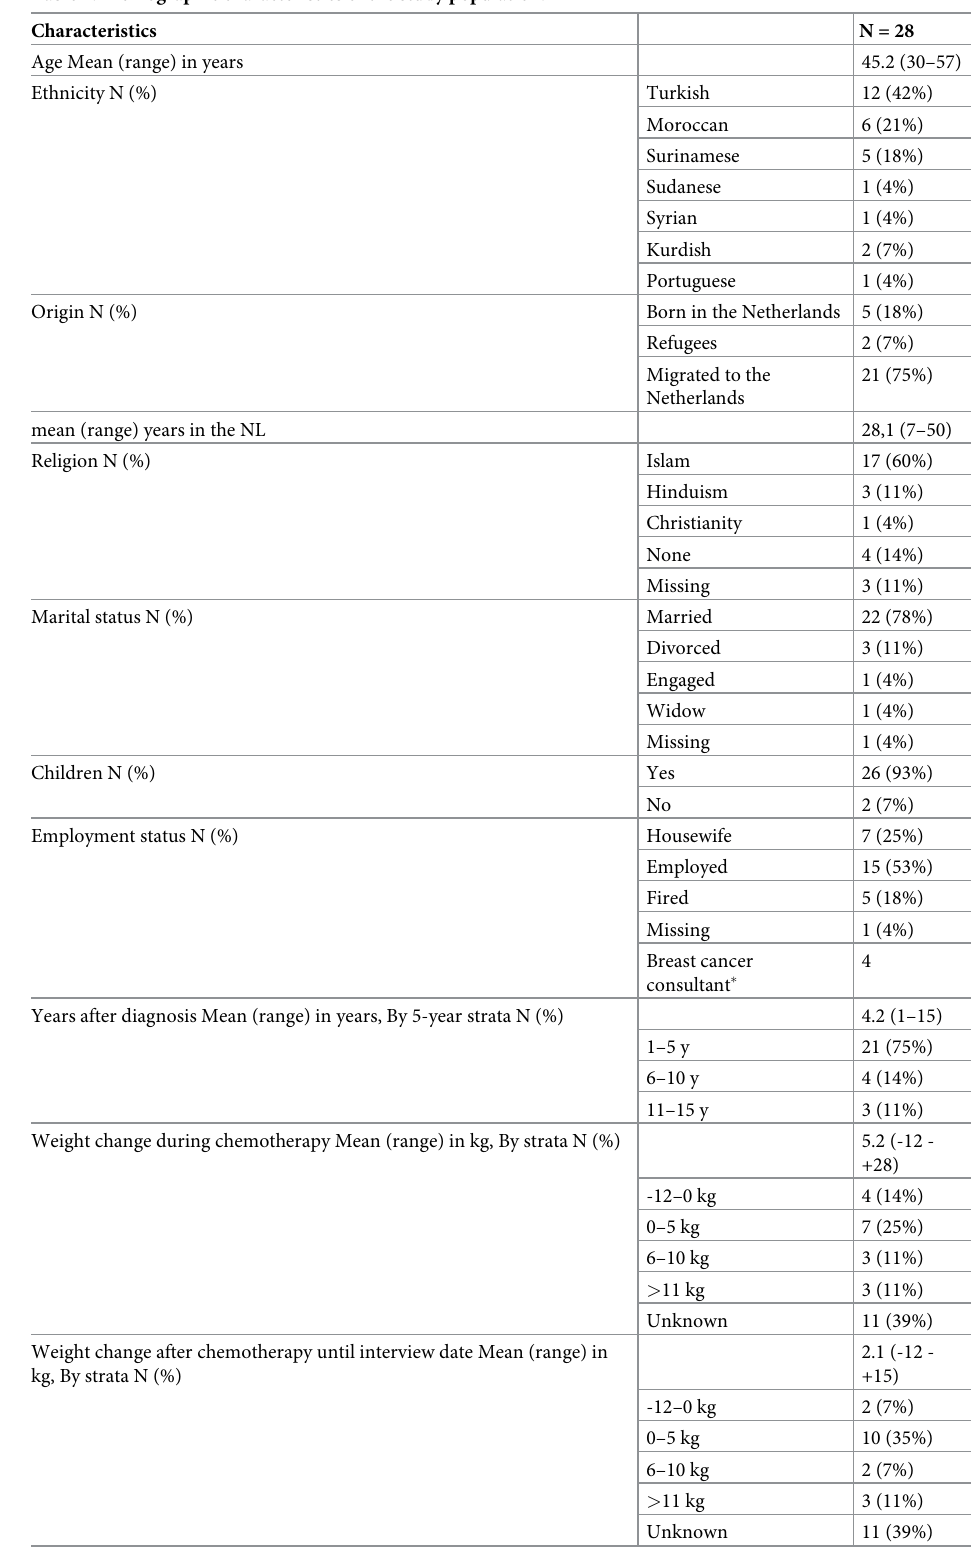
Table 1. Demographic characteristics of the study